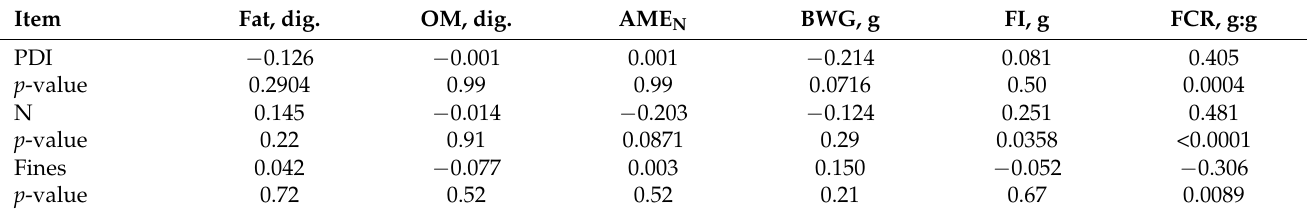
Table 13. Pearson’s correlations between feed physical proprieties and digestible and performance values of broilers in starter feed phase, 1 to 14